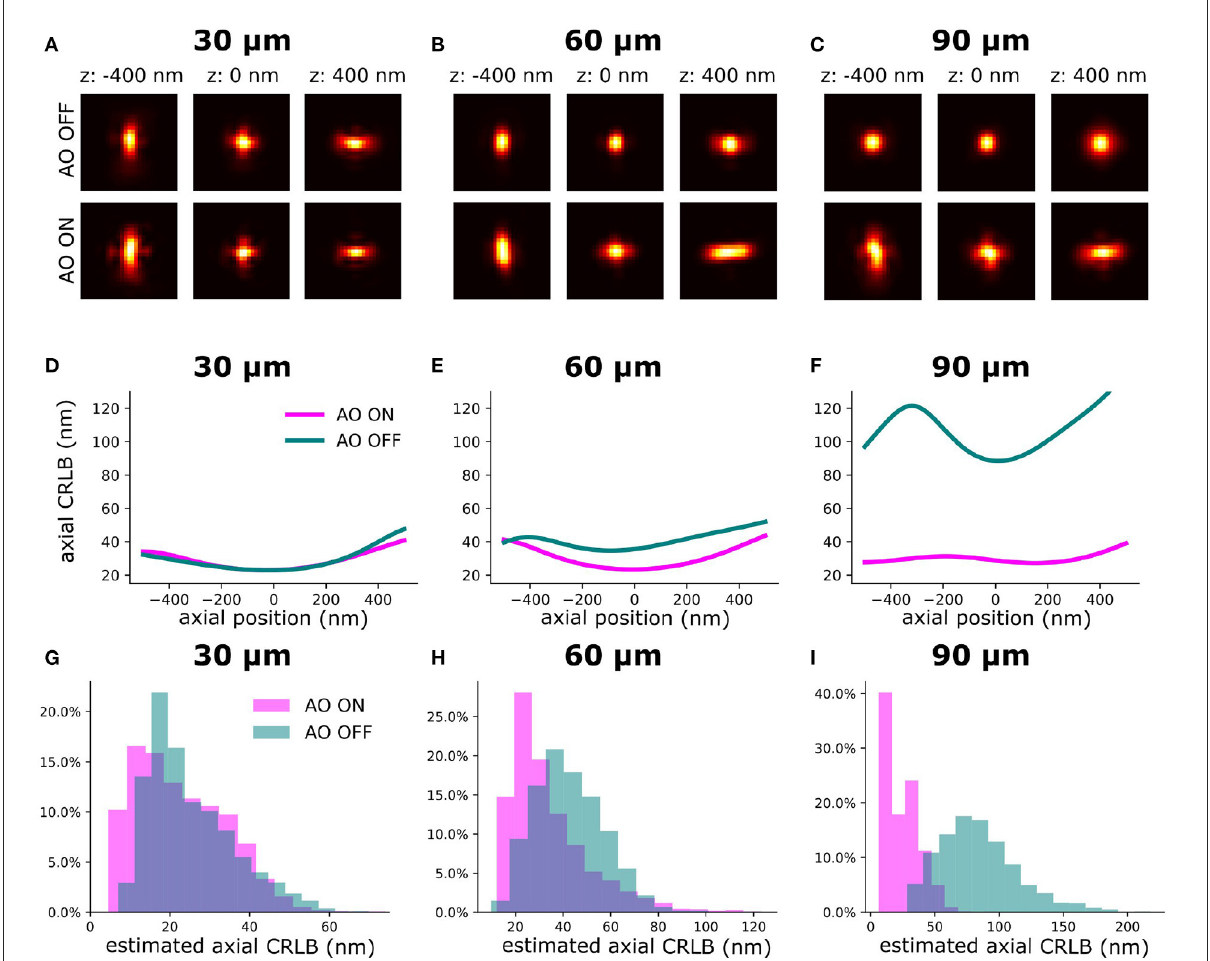
FIGURE3 The INSPR PSF before and after sensorless AO correction at different imaging depths. The PSF model was calibrated by imaging a fluorescence bead sample. (A–C) Estimated in-situ PSF models using the INSPR algorithm with and without AO correction at different depths (30, 60, and 90 µ m). (D–F) The theoretical axial CRLB based on the estimated PSF model from (A–C) with 3,000 photons of intensity and 50 photons/pixel of background. (G–I) The distribution of estimated axial CRLB at different imaging